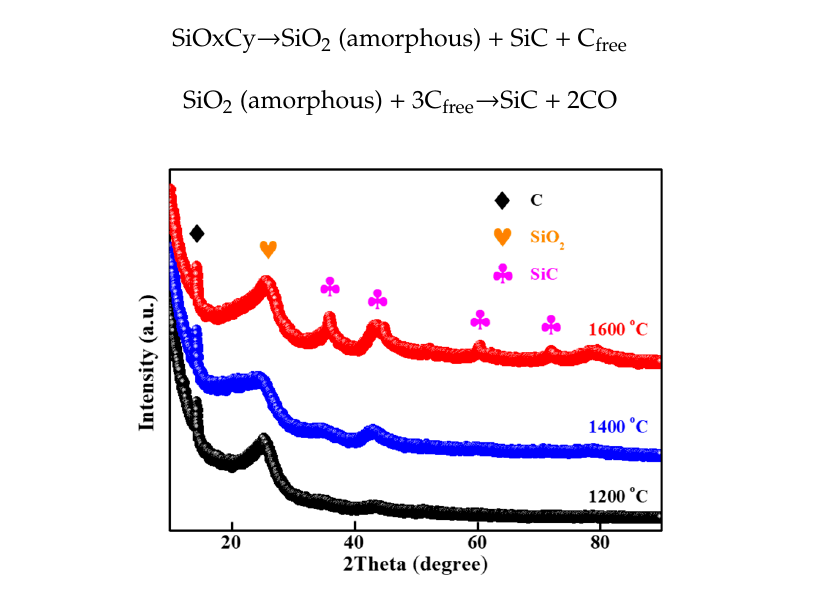
Figure 1. The XRD patterns of as-prepared composites after different pyrolysis temperatures.